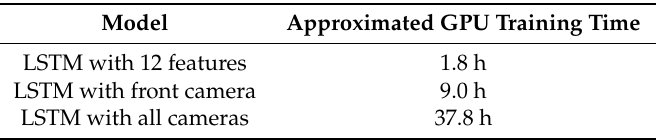
Table 3. Approximate training time of different